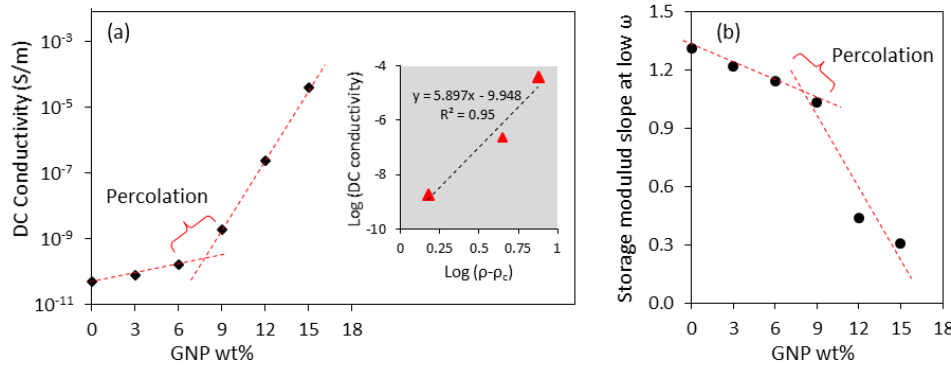
Figure 4. ( a ) Effect of GNP incorporation on the DC conductivity of PBAT and its electrical percolation, ( b ) rheological percolation of PBAT/GNP nanocomposites from dynamic frequency sweeps at 140 ◦